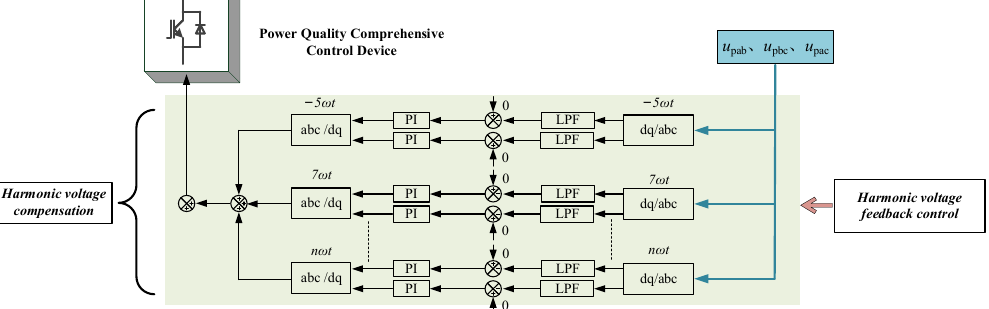
Figure 4. The compound control strategy of voltage feedback + current feed forward. In Figure 4, voltage feedback control ensures the precision of harmonic voltage control, and current feed-forward control ensures the dynamic response speed of harmonic voltage control. Voltage feedback control is when three voltage sensors detect the PCC point voltage, extract each harmonic voltage component to obtain the feedback voltage value and then superimpose it to the command voltage value for control. Current feedforward control is when three current sensors detect the current at the PCC point, and then extract the harmonic components and compensate the virtual impedance to suppress the harmonic components. The harmonic voltage feedback control strategy proposed in this paper is shown in Figure 5. In the figure, the harmonic voltage feedback control realizes the suppression of the harmonic voltage at the PCC point.